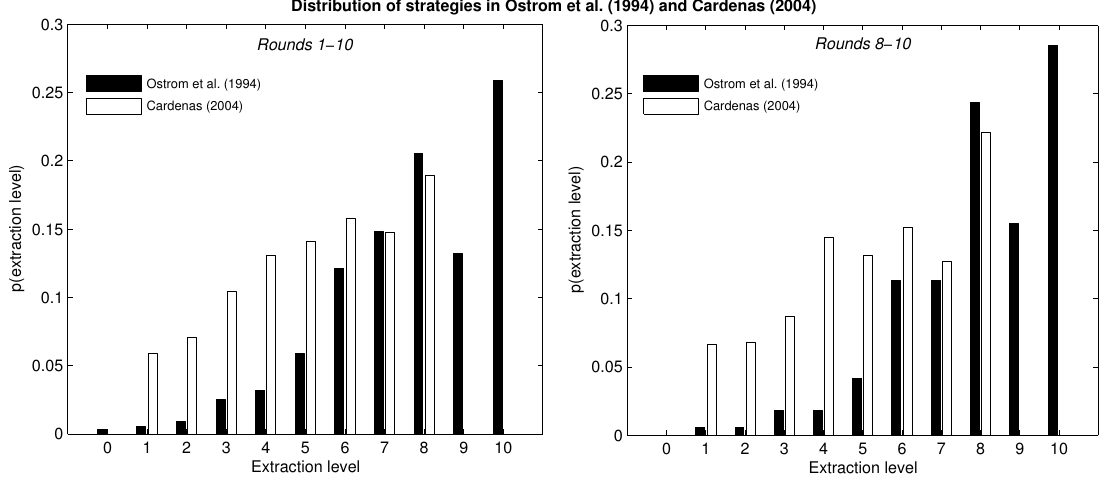
Figure 1. Distribution of strategies in Ostrom et al. (1994) and Cárdenas (2004).